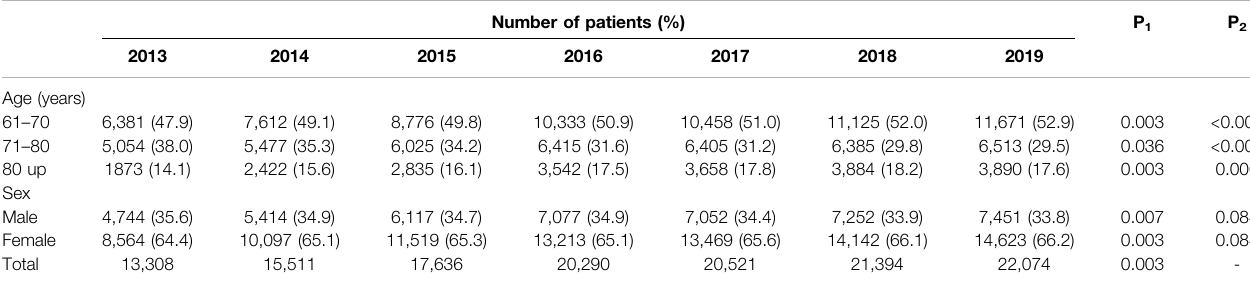
TABLE 1 | Demographic information of old DED patients for the included